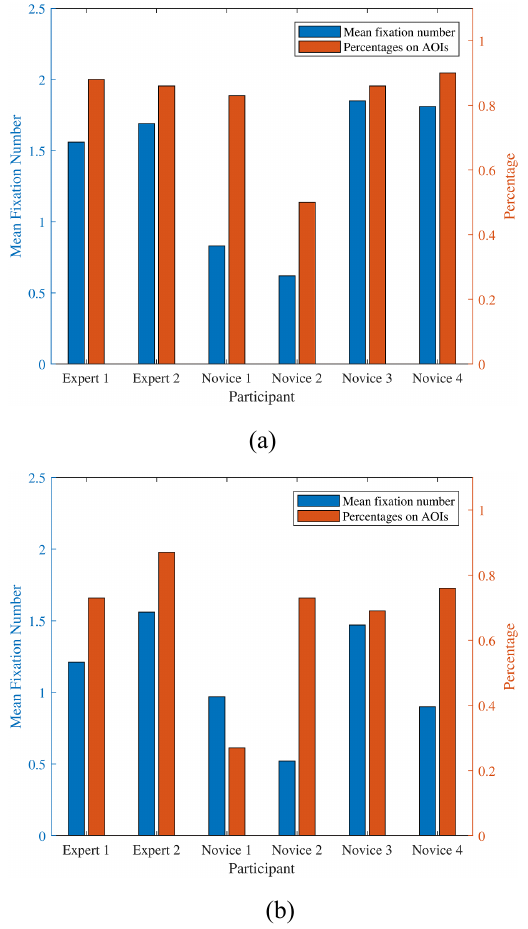
Figure 5: Mean fixation number and total fixation per- centage on AOIs at (a) target stage one, and (b) target stage